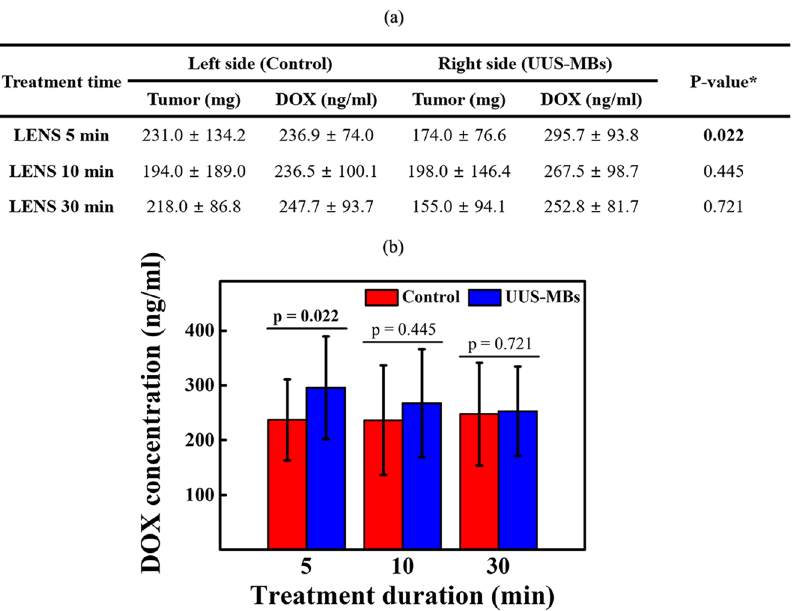
Figure 5. Doxorubicin concentration within the tumor in a rat xenograft hepatoma model. ( a ) Doxorubicin concentration in the subcutaneous hepatoma rat models with unfocused ultrasound-mediated microbubbles. ( b ) Graph of the change in DOX concentration according to ultrasound